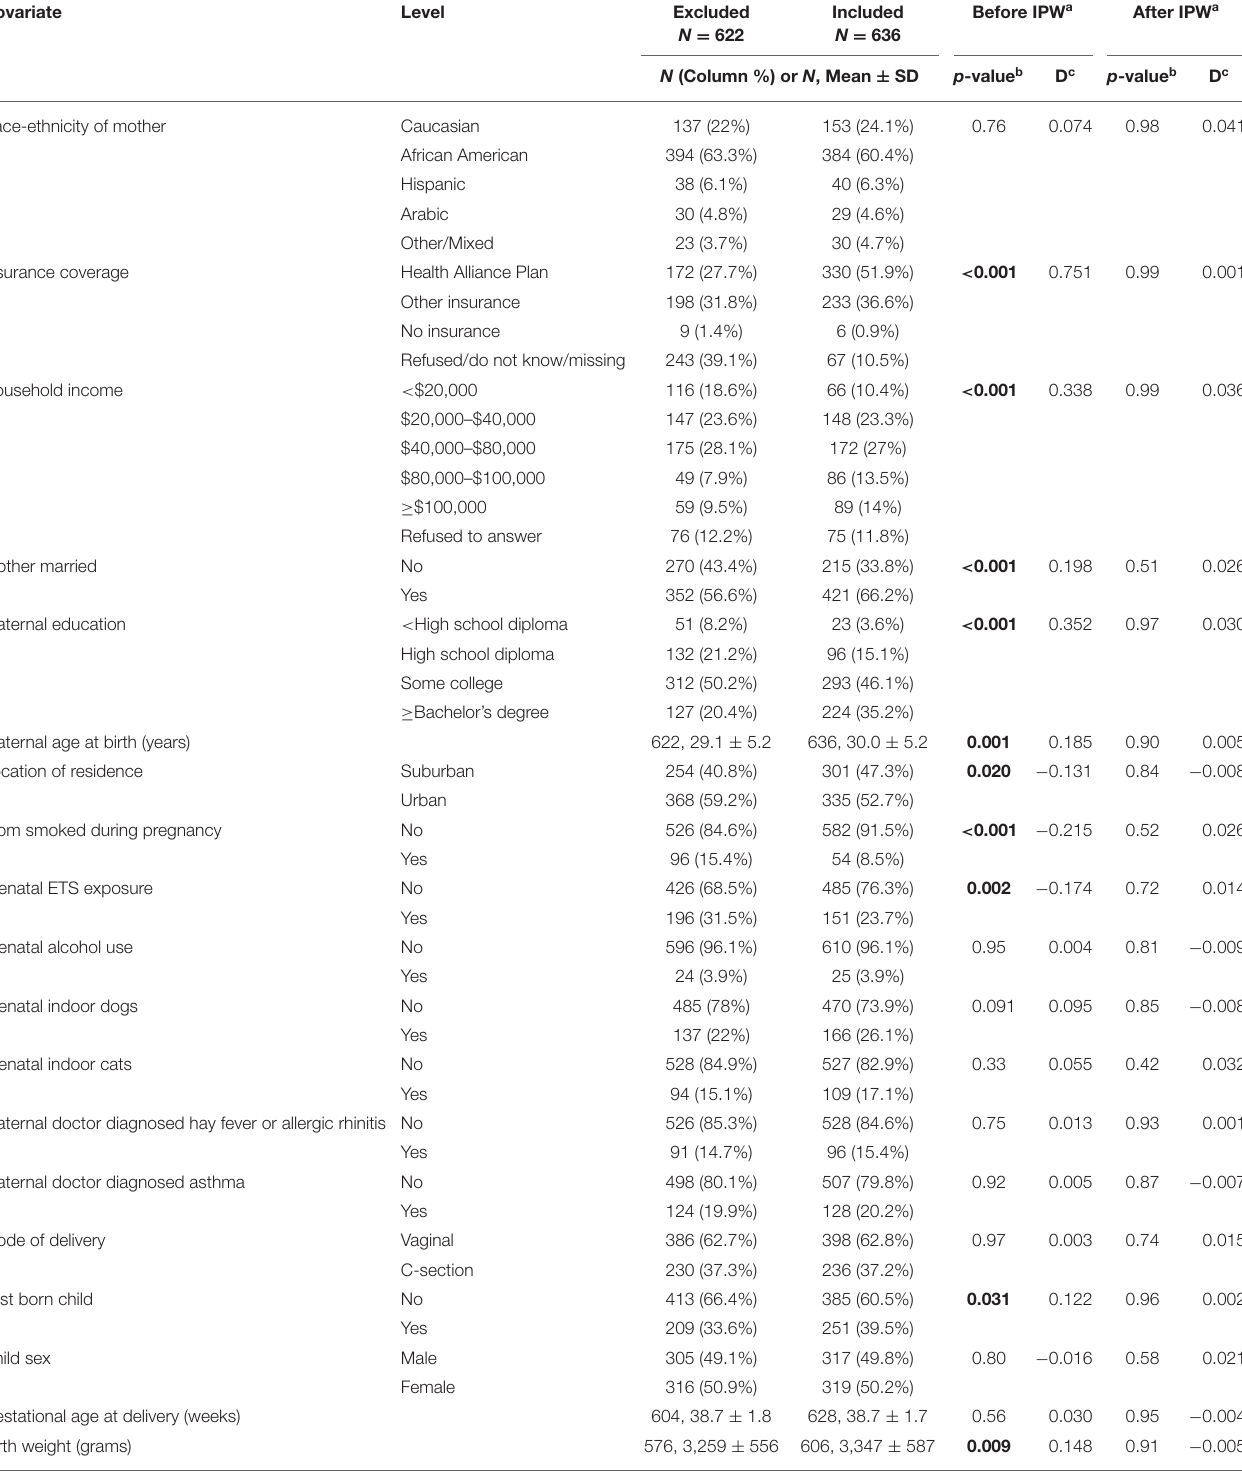
TABLE 1 | Description of maternal-child pairs included and excluded from the analysis.